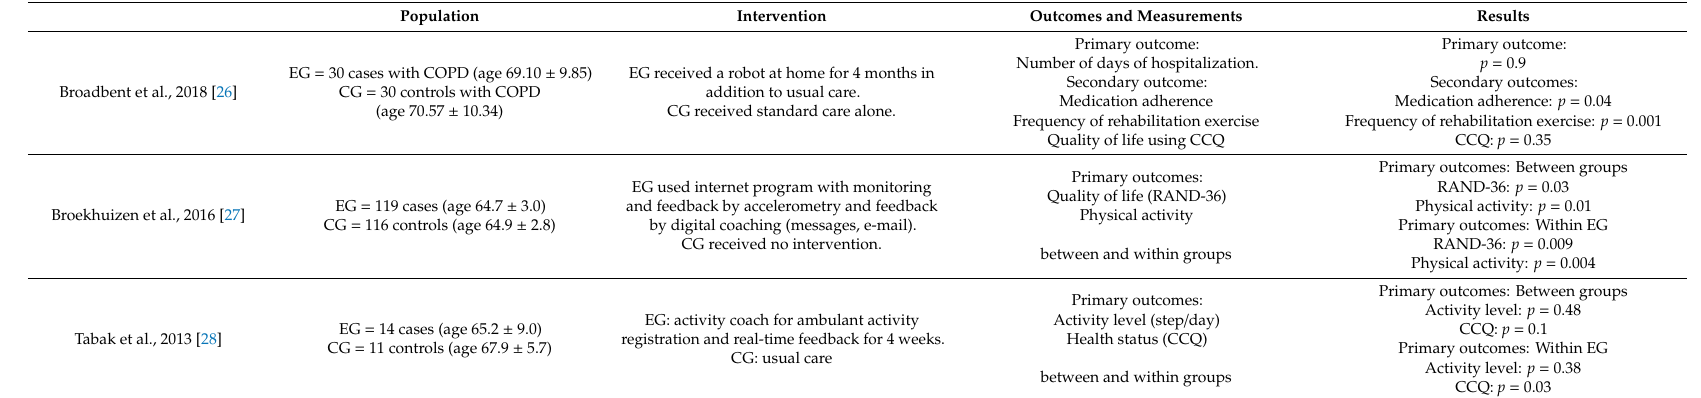
Outcomes and Measurements Results